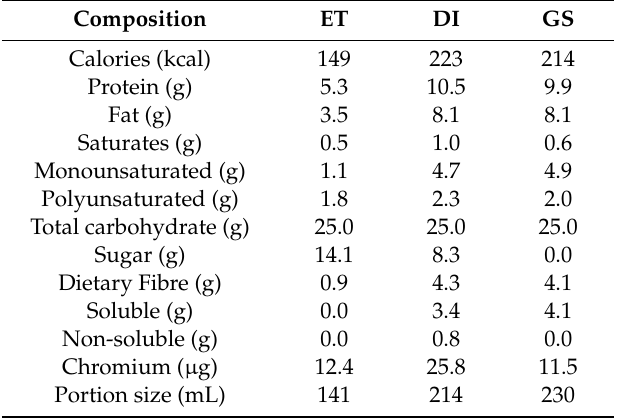
Table 2. Nutrient composition of oral nutritional supplements based on 25 g available